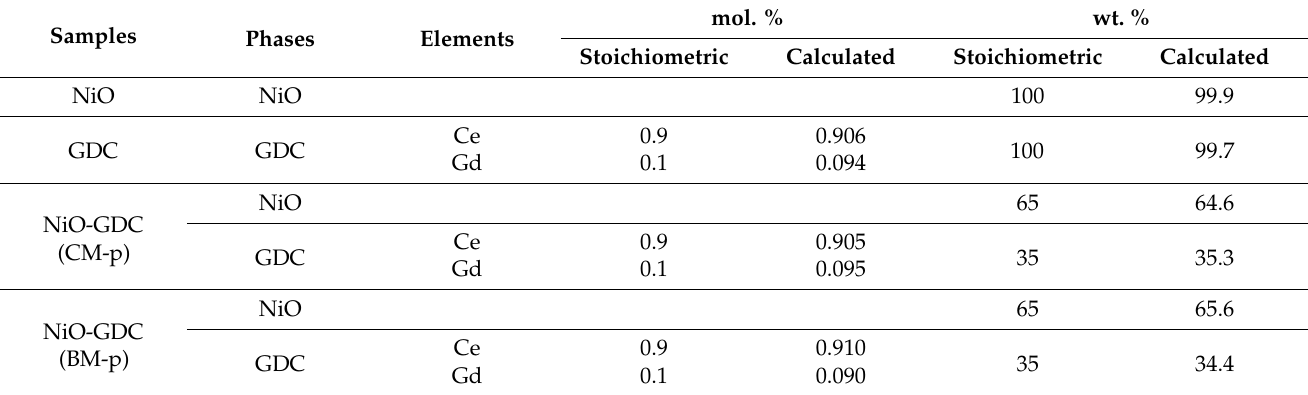
Table 1. XRF results of NiO, GDC, and nanocomposite powders obtained by CM and BM method. mol. % wt. % Samples Phases Elements Stoichiometric Calculated